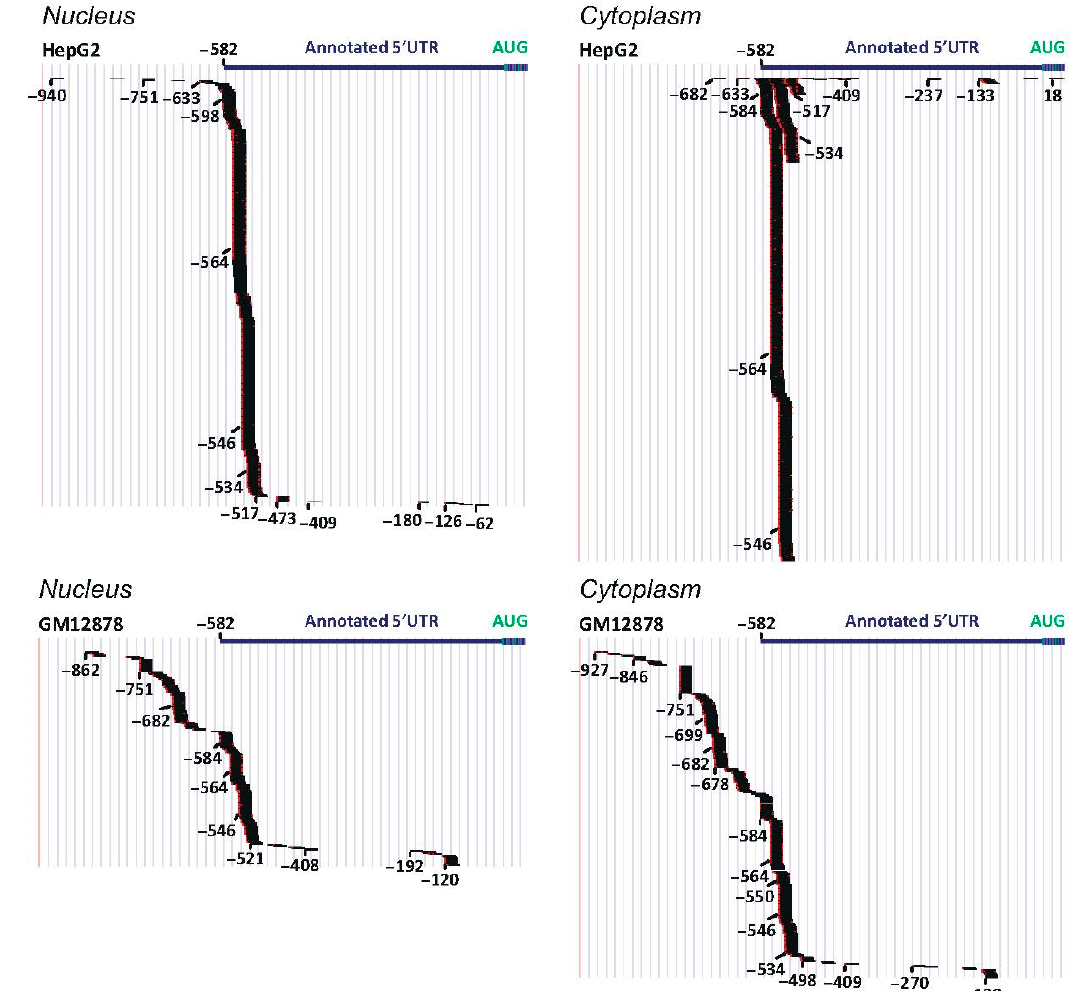
Figure 3. Initiation of TRIB1 transcription from multiple sites within a core promoter. Visualisation of CAGE tags in the promoter region of TRIB1 . Blue bar represents Ensembl-annotated TRIB1 5 ′ UTR. Numbering, in base pairs, is from the translation initiation codon (AUG, green). Each horizontal black bar represents a capped transcript: n = 1435 and 429 (nucleus) and 1670 and 534 (cytoplasm) in the 1kbp upstream of the translation initiation codon AUG in HepG2 and Epstein– Barr-virus-transformed lymphoblastoid cell line GM12878, respectively. Annotated sequence from the GRCh37/hg19 Assembly, drawn to scale.